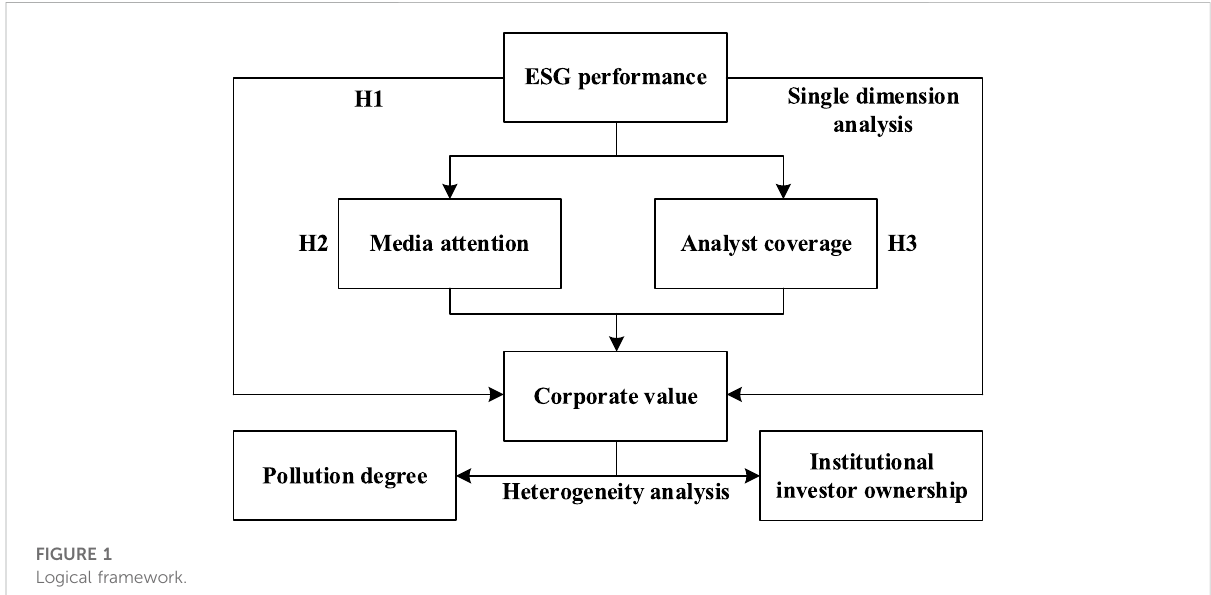
FIGURE 1 Logical